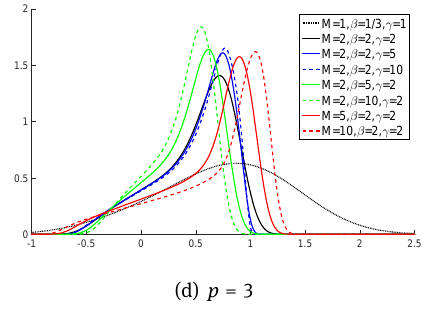
, and several choices of the parameters M > 1− 3 Kt ; M , β , γ